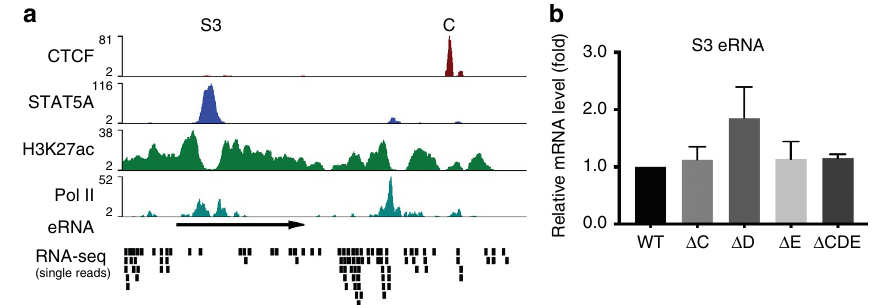
Figure 7 | Wap super-enhancer eRNA levels are independent of CTCF sites. ( a ) Structure of the S3 region of the super-enhancer. Site S3 is characterized by STAT5 binding, extensive H3K27ac, Pol II binding (GSE74826) and the presence of eRNAs (based on total RNA-seq data). Transcripts coincided with site S3 and additional STAT5-binding sites. An eRNA associated with S3 was identified and characterized using 5 0 and 3 0 RACE (Supplementary Note 2). ( b ) No statistically significant differences in S3 eRNA levels between mammary tissue from wild type and the mutants were observed. One-way ANOVA with multiple comparison and alpha 0.01 was applied ( P ¼ 0.26). Results are shown as the means ± s.e.m. of independent biological replicates; D C n ¼ 9 ( (cid:2) / (cid:2) ); D D n ¼ 5 ( (cid:2) / (cid:2) ); D E n ¼ 6 ( (cid:2) / (cid:2) ); D CDE n ¼ 3 ( (cid:2) /